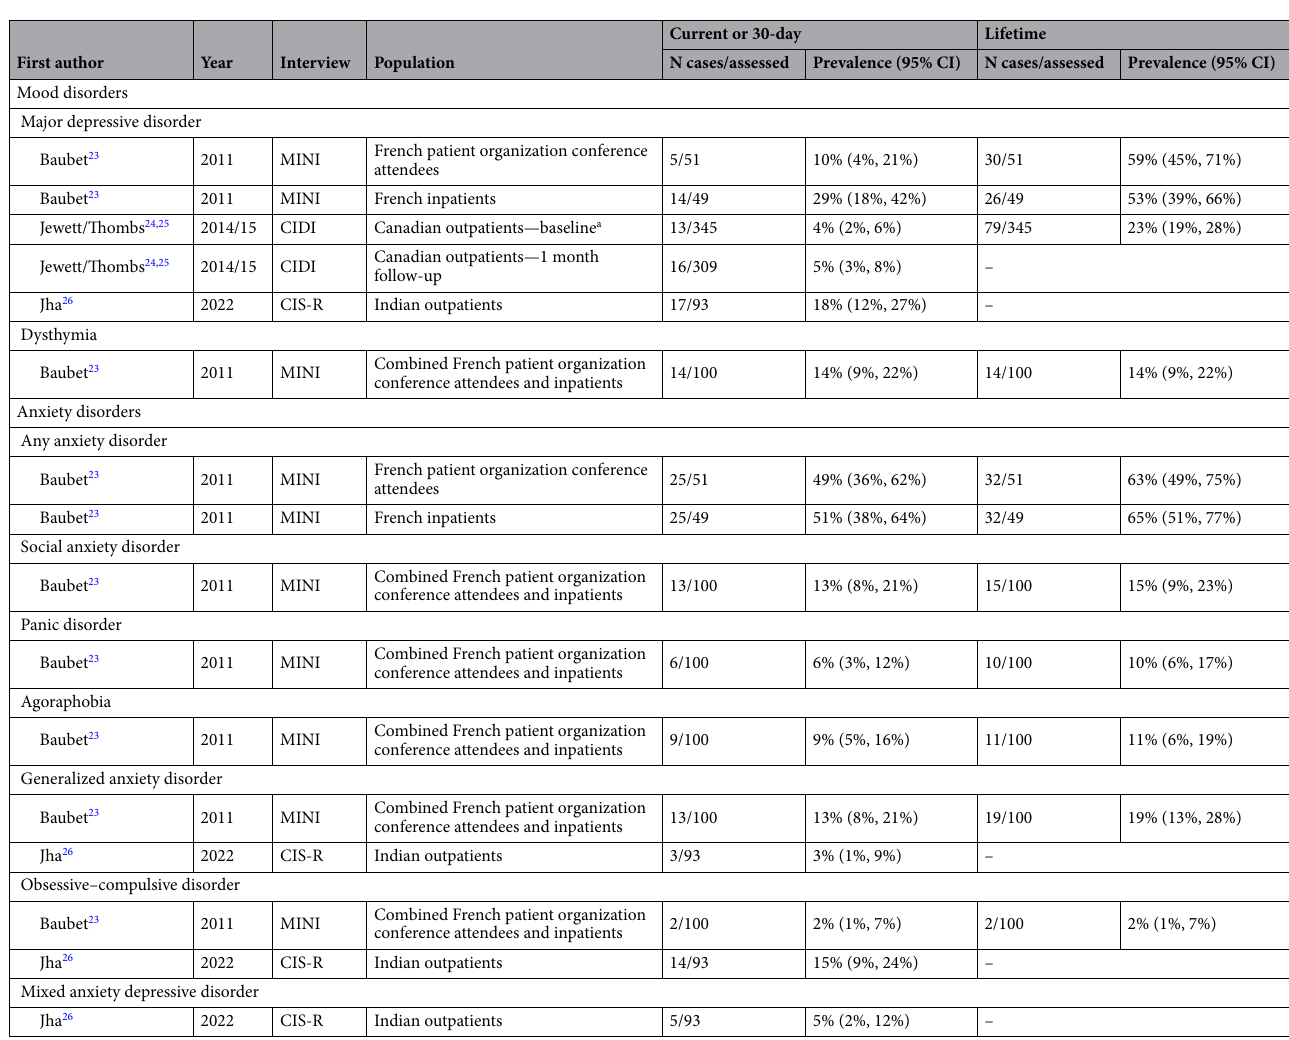
Table 2. Prevalence of mood and anxiety disorders. CIDI composite international diagnostic interview, CIS- R revised clinical interview schedule, MINI mini international neuropsychiatric interview. a The study